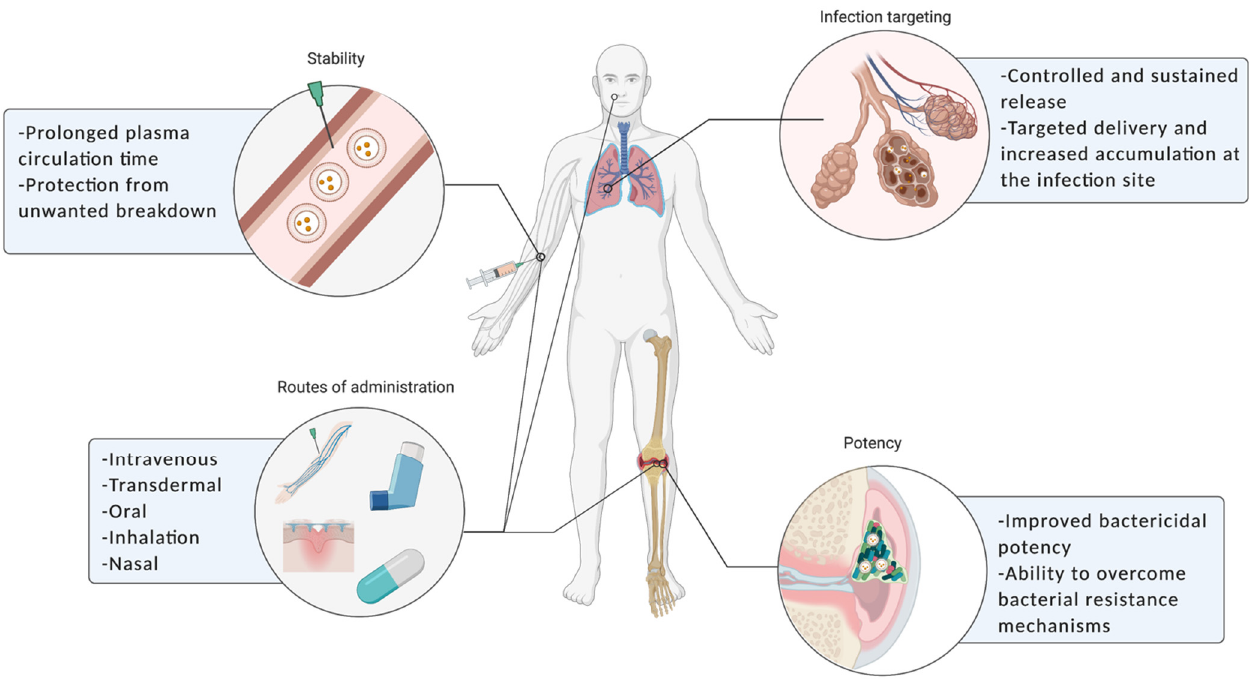
Figure 2. Schematic representation of the main advantages of liposomes as antibiotic carriers.